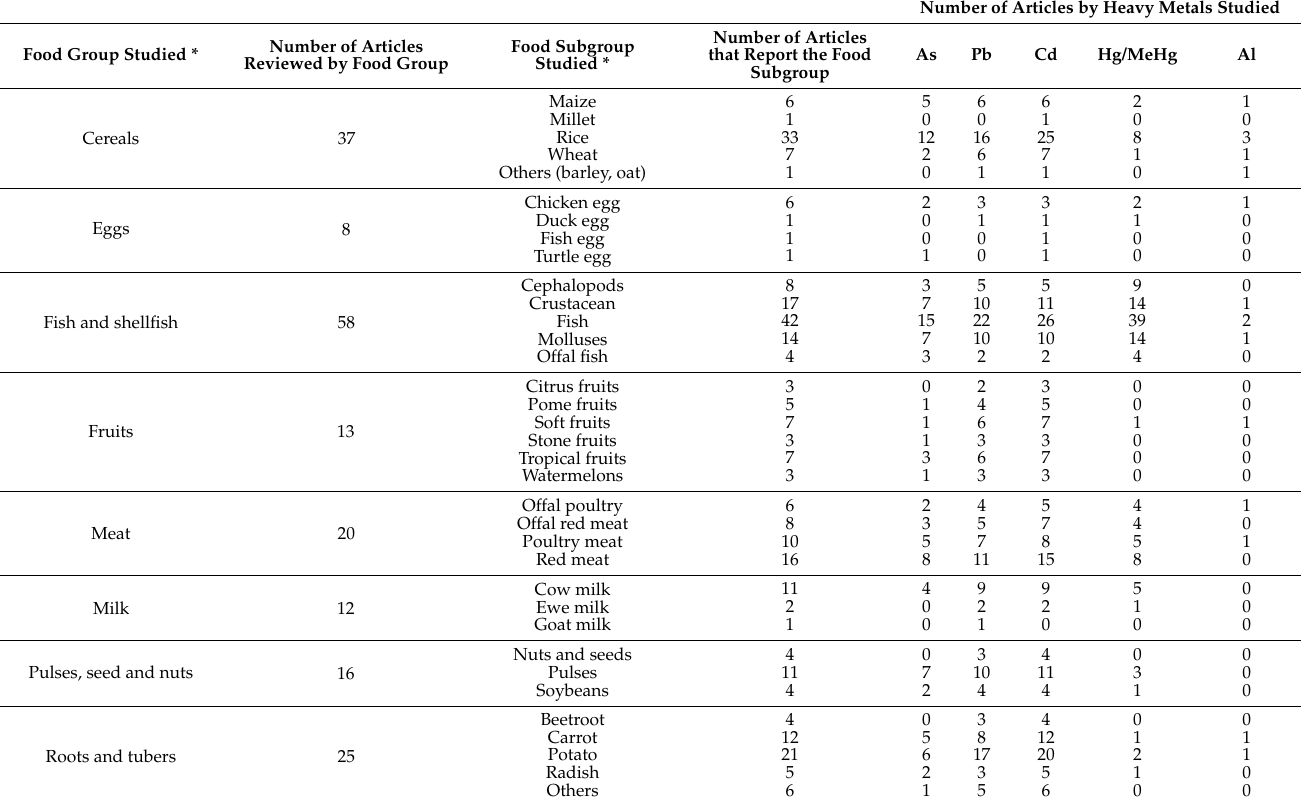
Table 2. Description of number of food groups and food subgroups, reported in the different studies included in this review, as well as the number of times that heavy metals were evaluated in the corresponding food